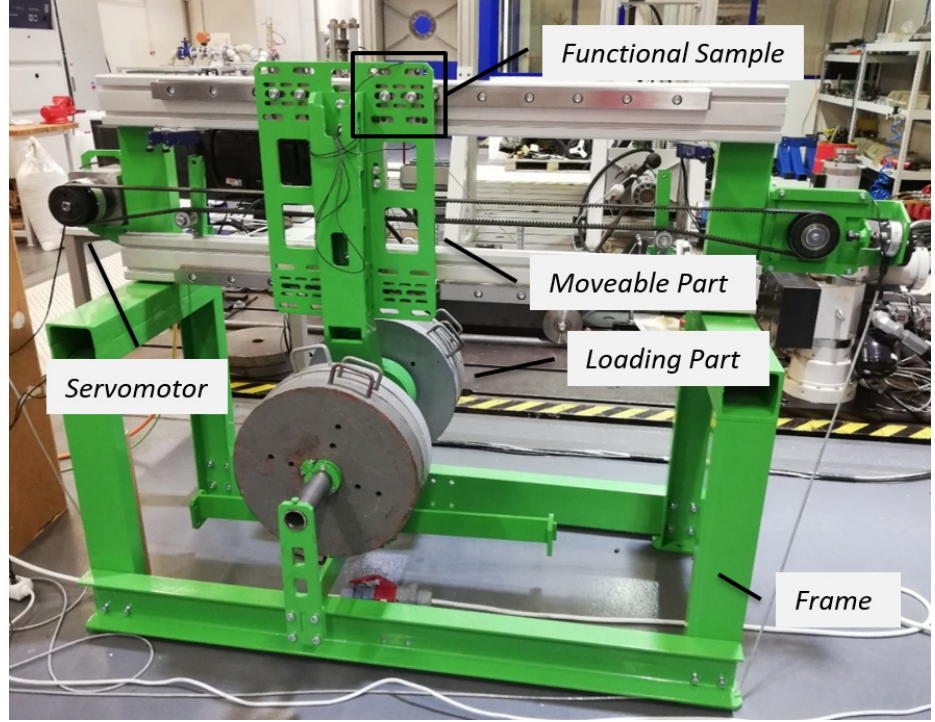
Figure 2. Test setup.